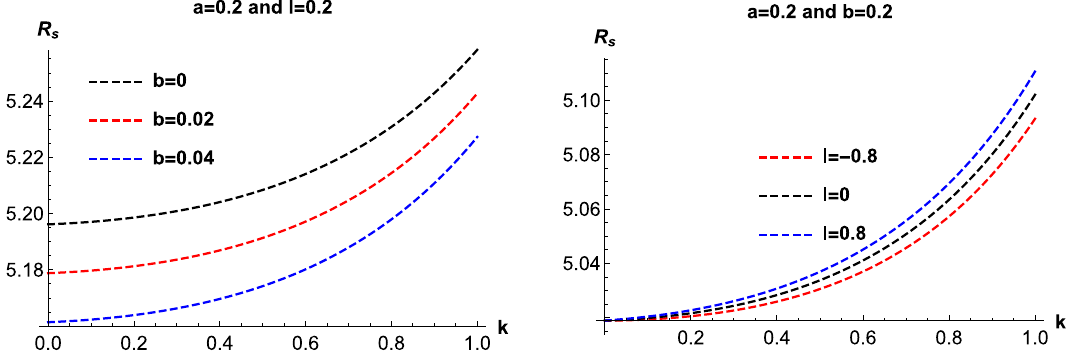
Fig. 11 The left one represents the variation of shadow radius R s with k for different values of b with a = 0 . 2 and l = 0 . 2. The right one represents the variation of R s with k for different values of l with a = 0 . 2 and b = 0 . 2